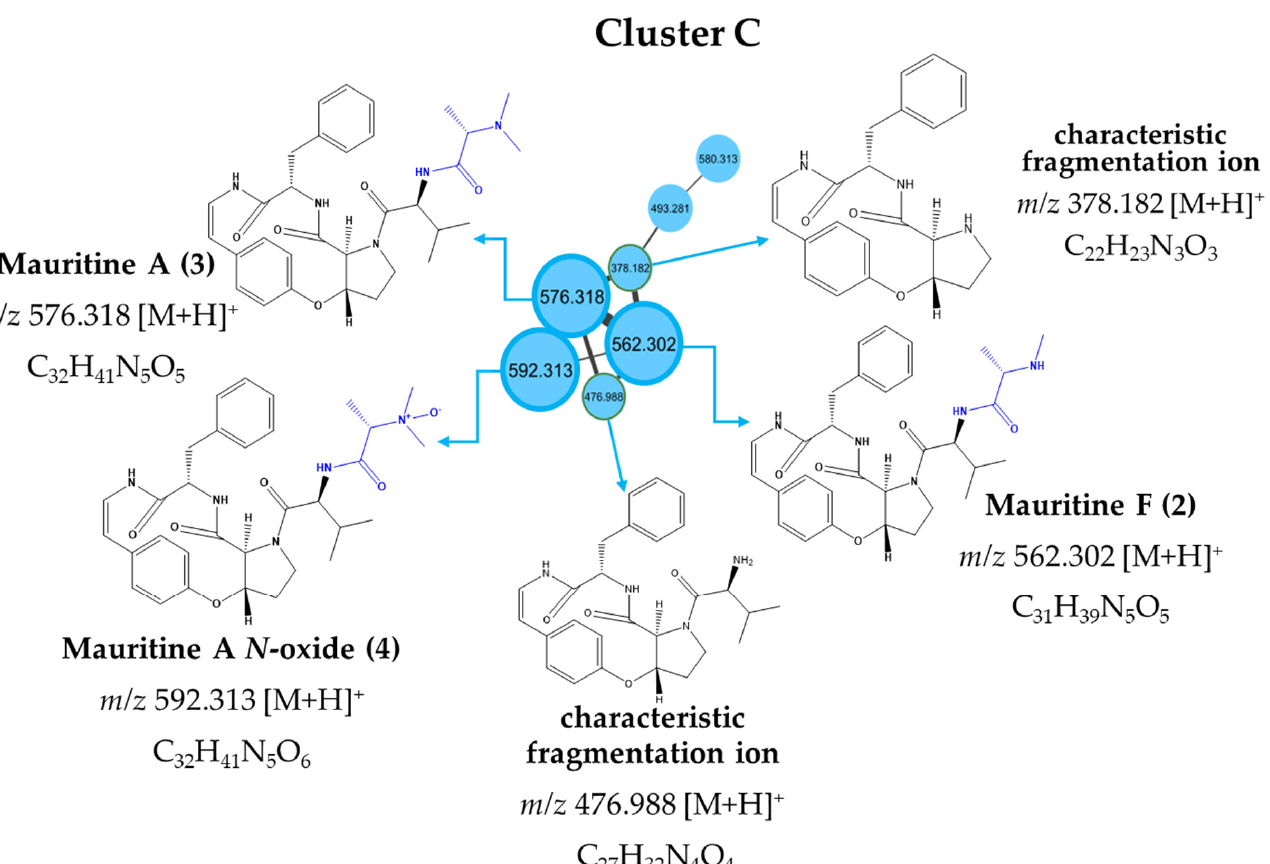
Figure 2. Putative annotation of cluster C with three cyclopeptide alkaloids compounds.